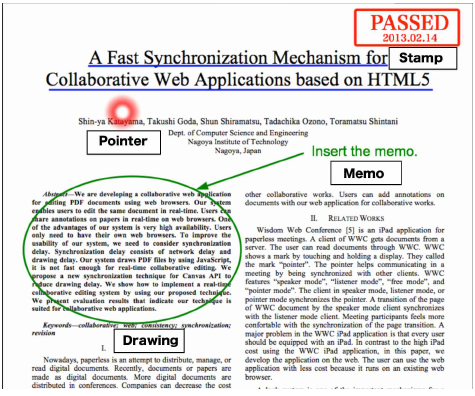
Fig. 5. Annotations on a document.